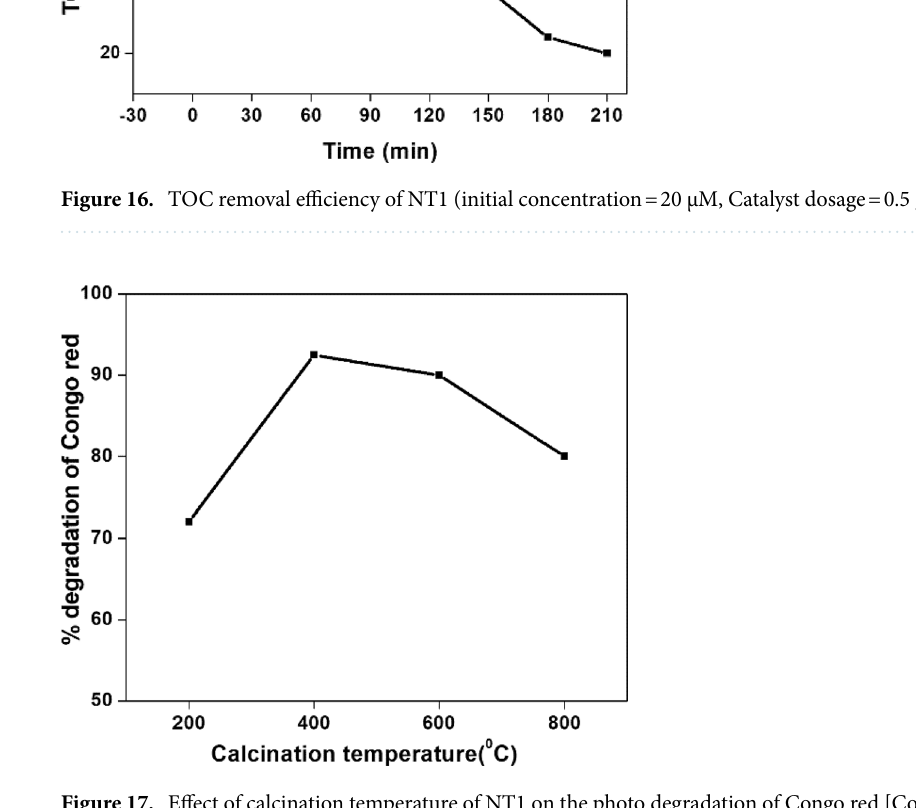
Figure 17. Effect of calcination temperature of NT1 on the photo degradation of Congo red [Congo red] = 20 µM, pH = 4, Amount of NT1 = 0.5 g l −1